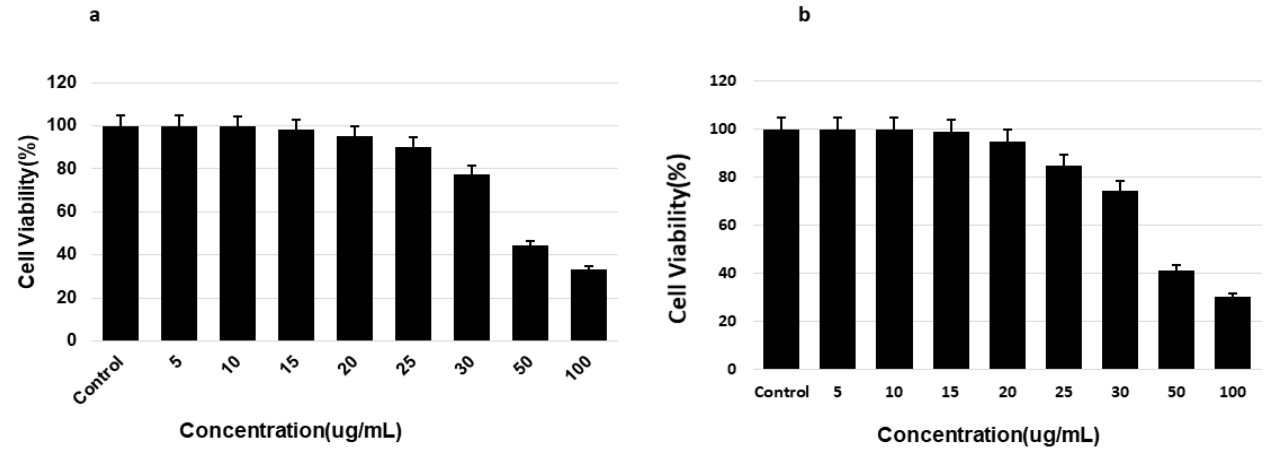
Figure 2. Determination of non-toxic concentration level of theasaponin E1 to SHY-5Y neuroblastoma and glial cells ( a , b ), respectively via MTT assay. Cells were cultured in their respective media in a 96-well microtiter plate. After attachment and treatment with saponin, cell viability was determined for each dose by reading the absorbance of the wells after addition of the MTT reagent and calculation of the results. Cells without treatment were employed as the control. Data are shown as mean ± standard error of means (SEM) ( n = 3).